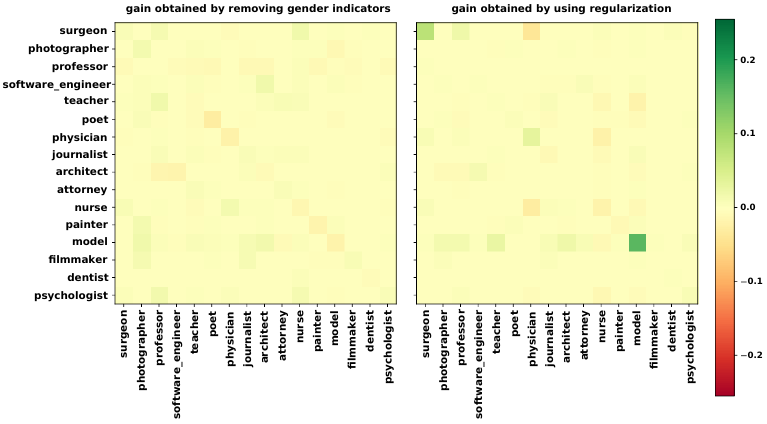
Figure 6. ( Left ) Difference between the baseline matrix of Figure 2 and the one obtained with an unbiased training set. ( Right ) Difference between the baseline matrix of Figure 2 and the one obtained using regularised optimisation. The greener the values, the more the technique has reduced the bias between men and women. The redder the values, the more the bias has been